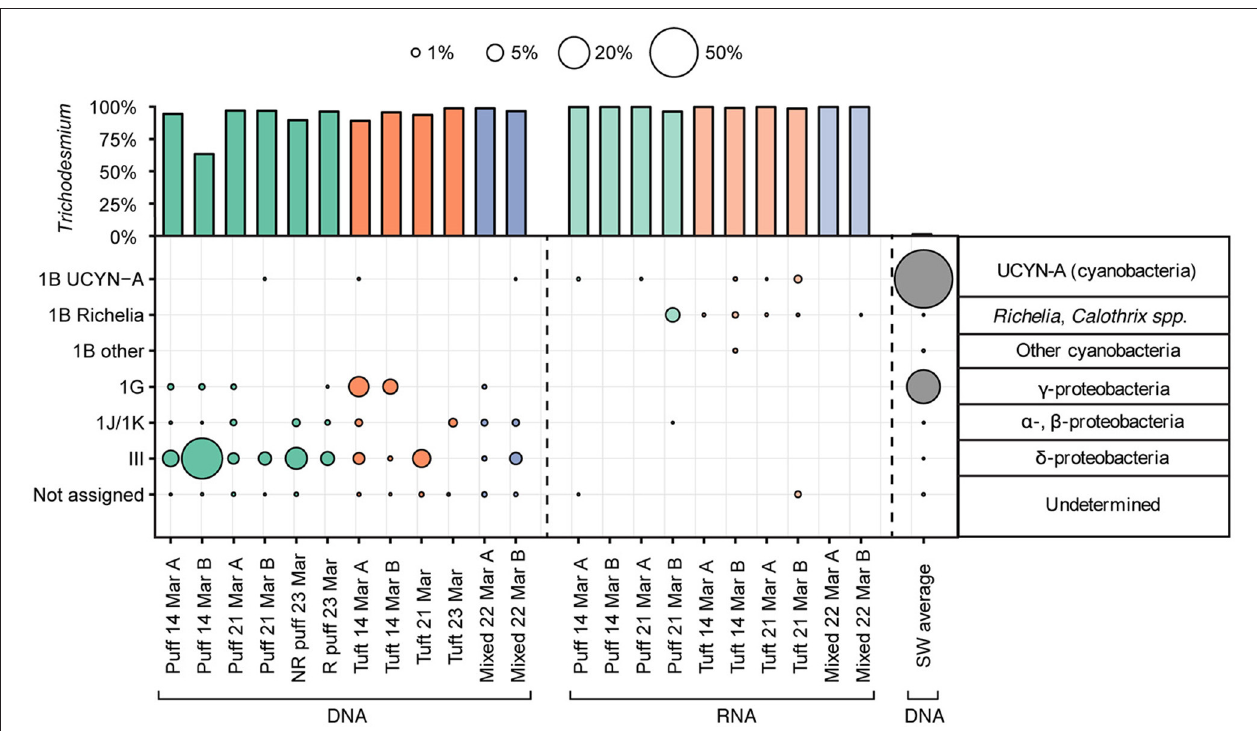
FIGURE 5 | Percentages of nifH gene (left, right) and transcript (center) sequences assigned to nifH cluster groups. Percentages of Trichodesmium sequences are displayed in the upper bar plot; sequences assigned to other taxa are displayed in the lower area plot. Representative taxa from canonical nifH clusters ( Zehr et al., 2003) are shown to the right. Color indicates the sample type/morphology [green, red, blue, and gray for puff colonies, tuft colonies, mixed colonies, and bulk 25m seawater (SW), respectively]. R denotes radial and NR denotes non-radial puff morphologies (see Figure 1 ).